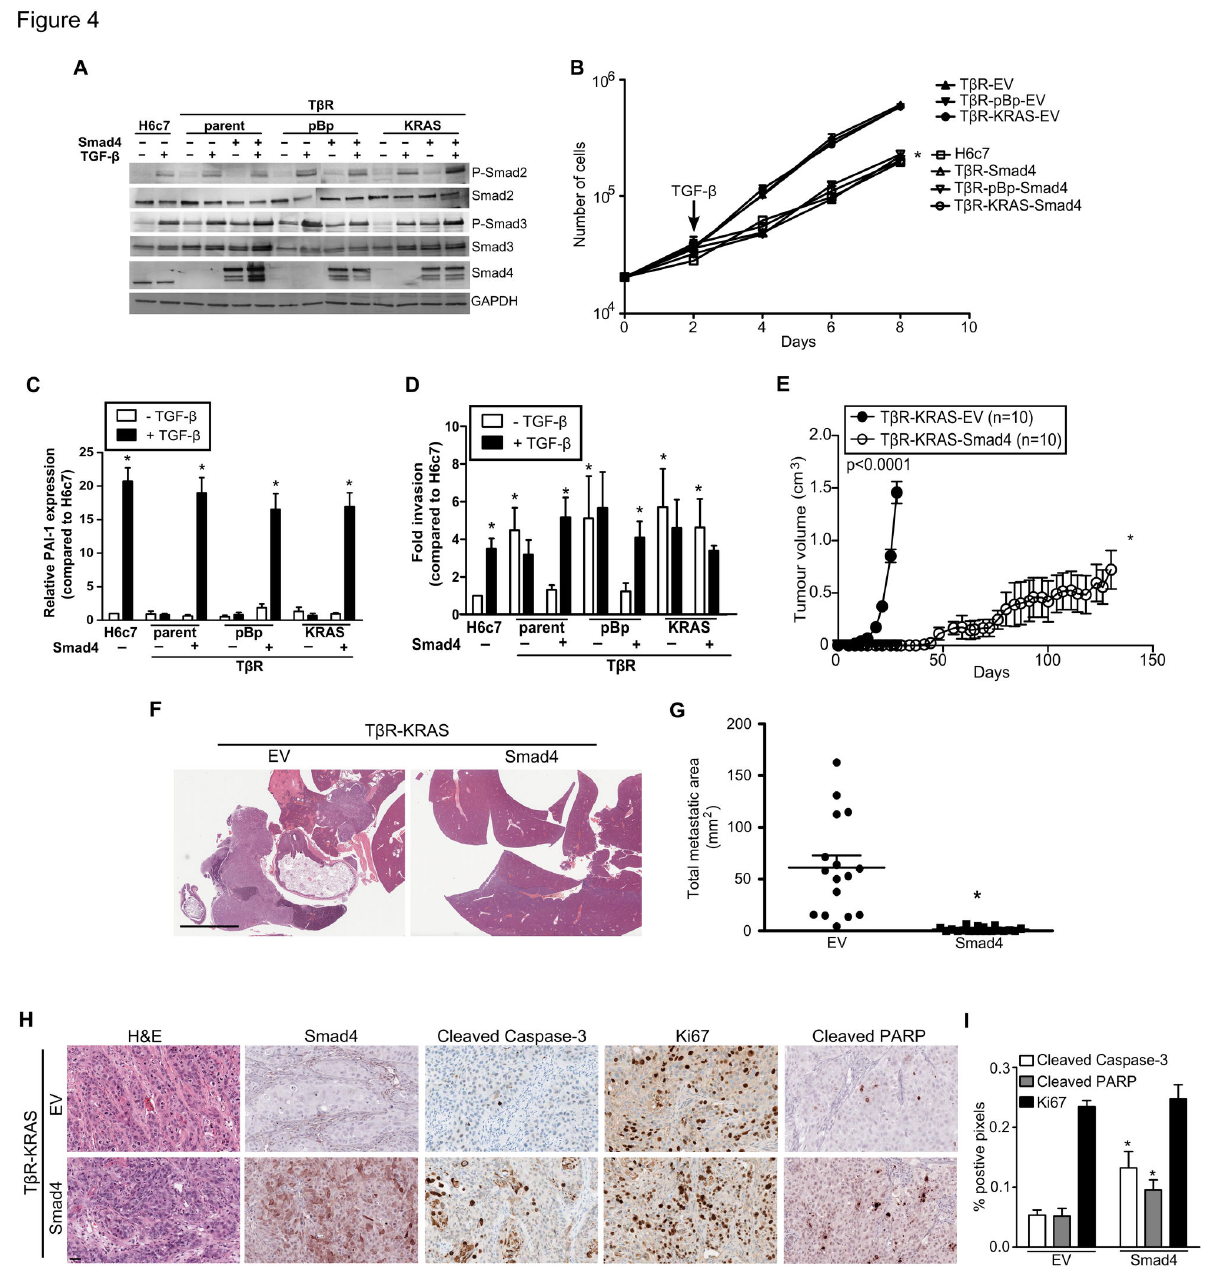
Figure 4. Smad4 expression restores TGF-β sensitivity and represses tumorigenicity in the TβR-KRAS cell line . ( A ) Immunoblots of phospho- and total Smad2/3, and Smad4. GAPDH was used as a loading control. ( B ) Growth curves of H6c7, TβR, TβR pBp, and TβR KRAS after restoration of Smad4 with TGF-β. ( C ) PAI-1 mRNA expression after 48 hours of TGF-β stimulation after forced Smad4 expression (n=3). ( D ) Invasion assays through Matrigel coated membranes incubated with and without TGF-β (n=6). ( E ) Tumor growth curves of TβR-KRAS- EV and TβR-KRAS-Smad4 (n=10). ( F ) The liver and spleens after orthotopic implantation of the TβR-KRAS and TβR-KRAS-Smad4 cell line. Scale bars represent 5 mm. ( G ) Total metastatic area of each TβR- KRAS-EV and TβR-KRAS-Smad4 orthotopic model. ( H ) Representative histological images of xenografts formed by TβR-KRAS-EV (n=16) and – Smad4 (n=19) cells after H&E, and immunostaining for Smad4, cleaved caspase-3, and Ki67. Scale bars represent 50 μm. ( I ) Quantification of Ki67, cleaved caspase-3, and cleaved PARP positive pixels of the TβR KRAS EV and – Smad4 xenografts. (* denotes significant differences between H6c7 and TβR cell lines or treated compared to vehicle where appropriate, two-way ANOVA, student t-test, or linear regression where appropriate, p<0.05; data are presented as mean ± SEM) . doi: 10.1371/journal.pone.0084366.g004 PLOS ONE |